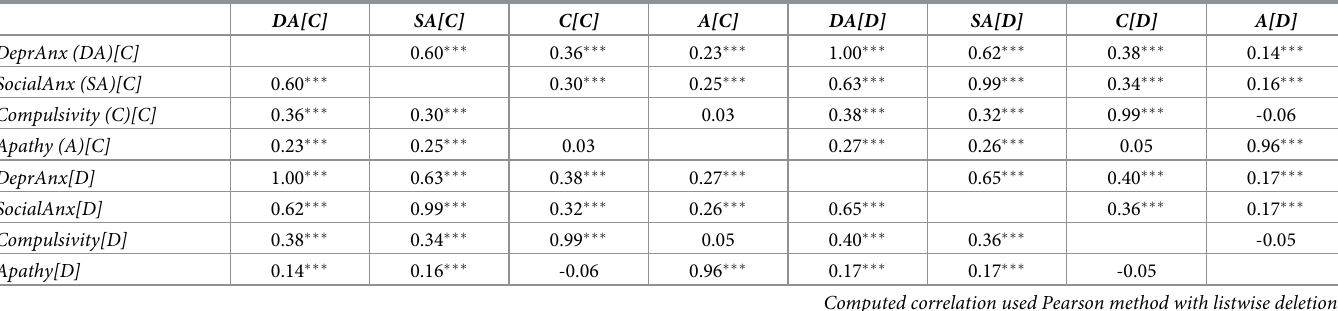
Table 2. Correlation between factor scores ( ��� p < 0.001) for the confirmation sample based on factor loadings from either exploratory factor analysis done on the confirmation sample (“[C]”) or based exploratory factor analysis from the discovery sample (“[D]”).